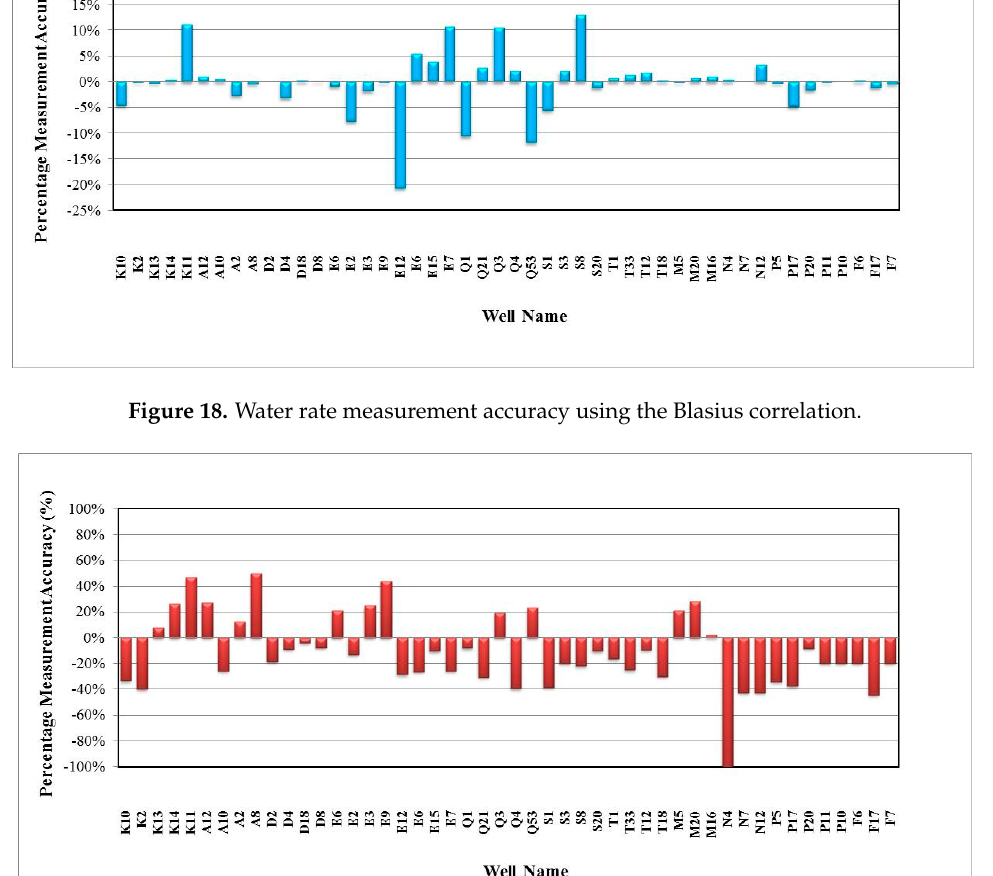
Figure 19. Gas rate measurement accuracy using the Blasius correlation.